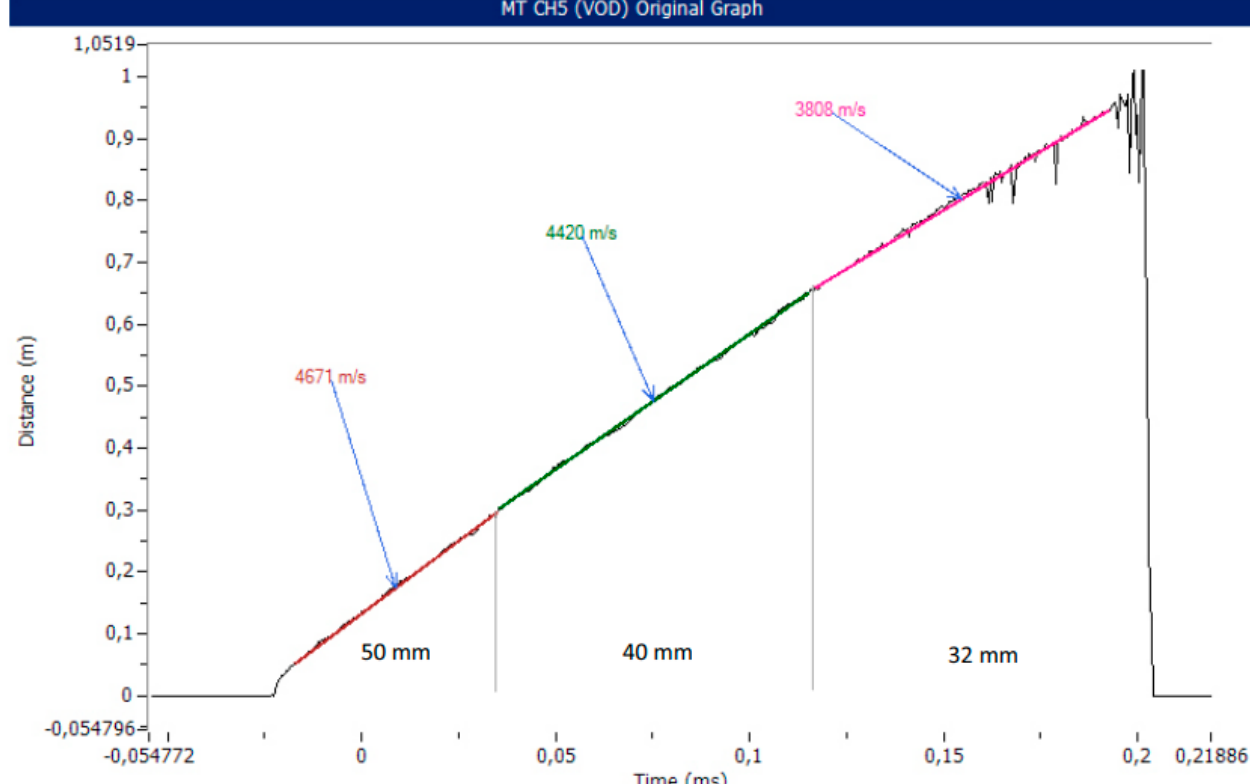
Table 1. Comparison of detonation composition and detonation velocity in commonly used,